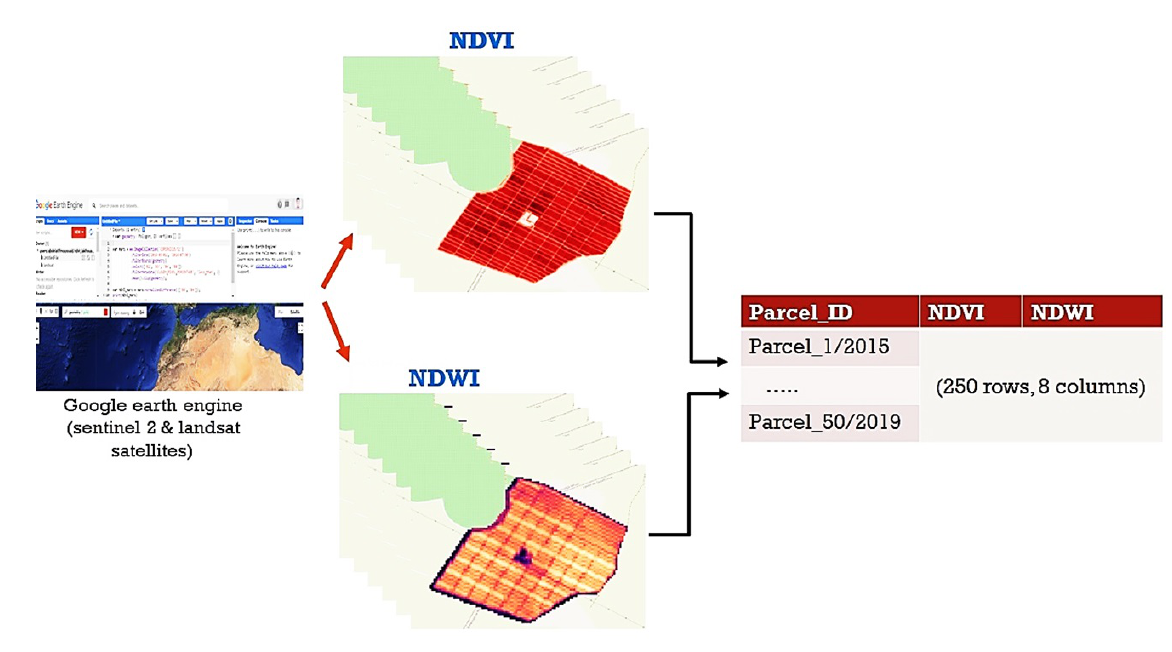
Figure 2. Spectral data acquisition.